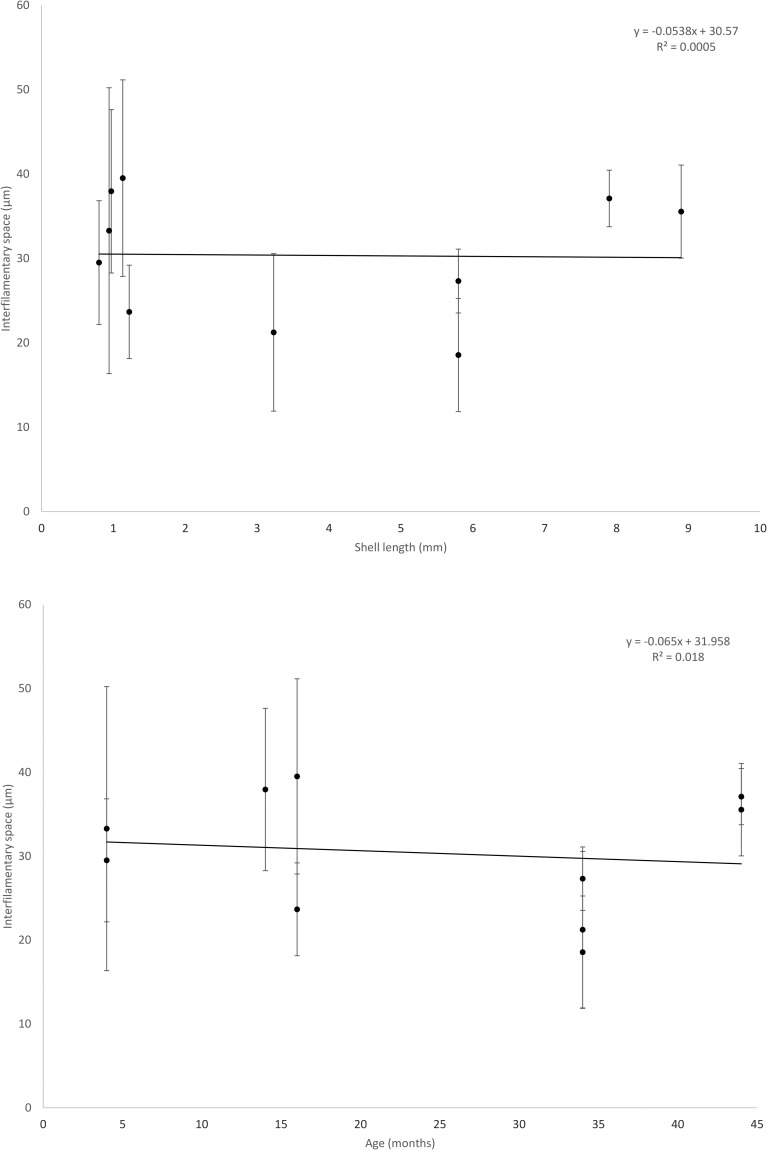
Interfilamentary space vs length (mm) and age (months).There was no significant trend of interfilamentary space with length nor age.